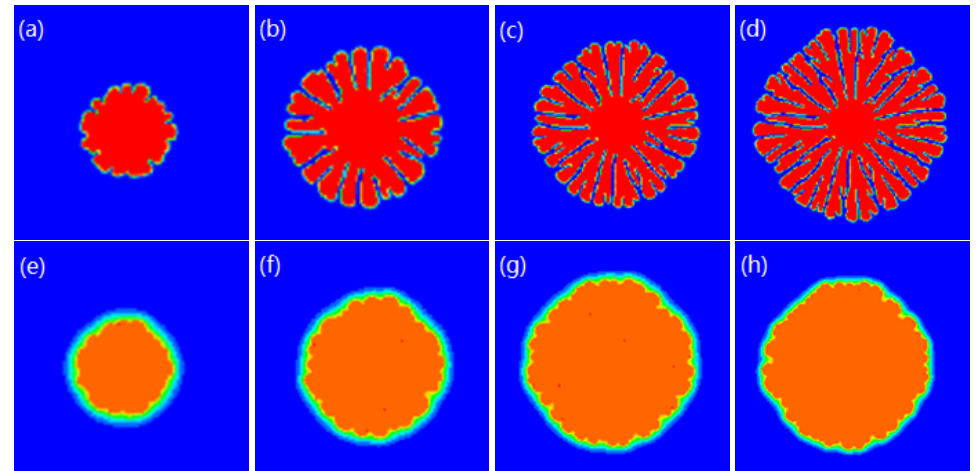
Figure 10. When K 0 = 1.4, under pure diffusion conditions, the morphology of the simulated spherulites and the corresponding temperature field distribution. (Under pure diffusion conditions, ( a – d ) is the crystalline morphology of the polymer, and ( e – h ) is the corresponding temperature field).